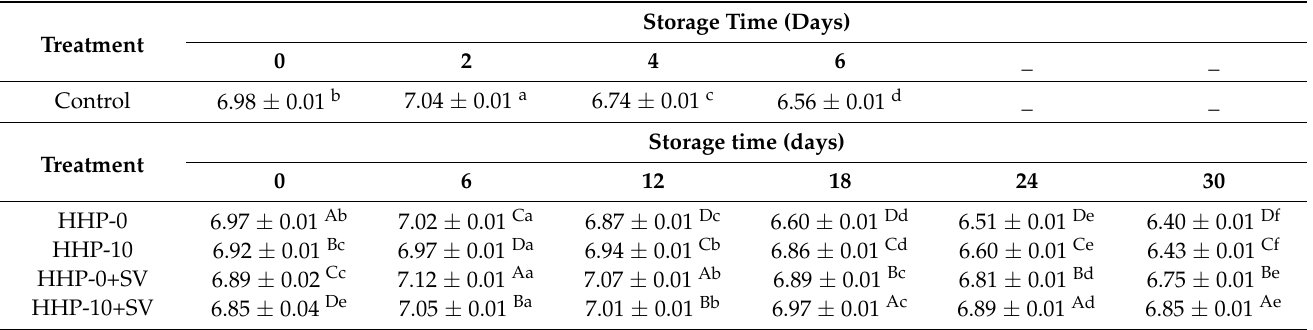
Table 1. Effects of different treatments on the pH value of largemouth bass during